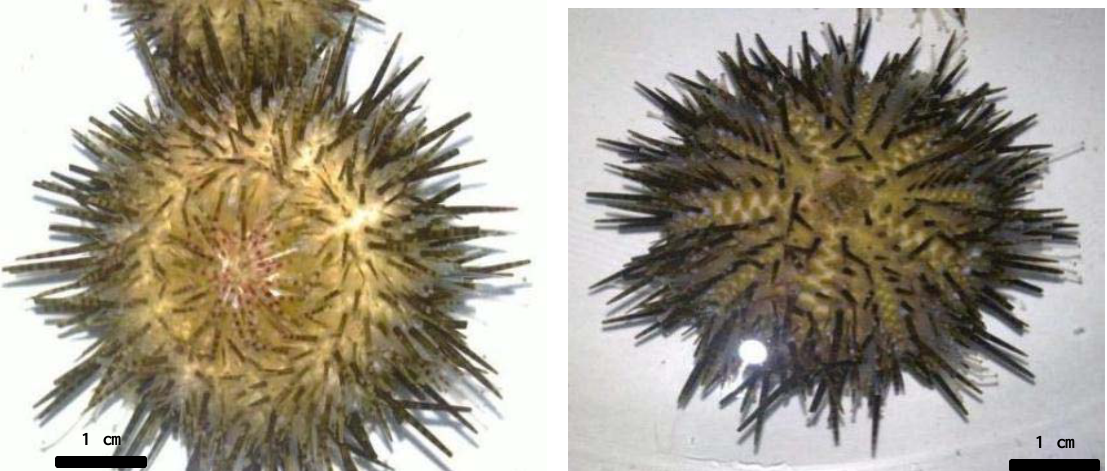
F IGURE 4. Temnopleurus toreumaticus (Leske,